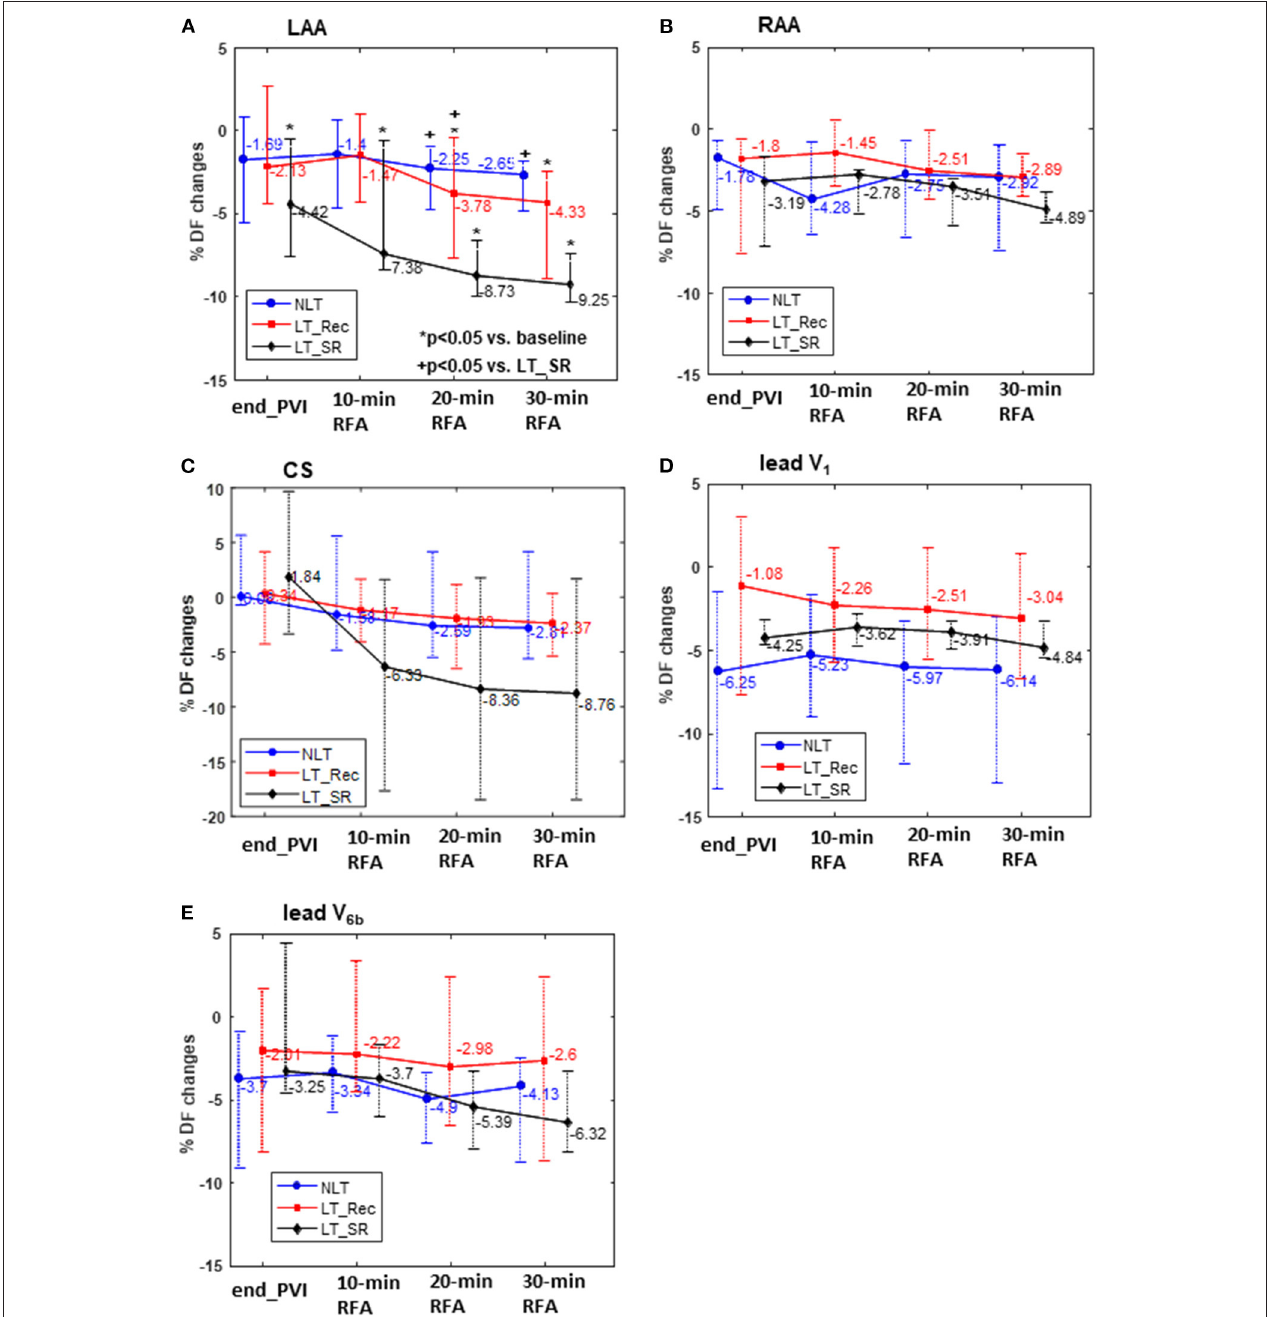
FIGURE 3 | Relative changes (%) in DF compared with the baseline DF at the end of PVI (endPVI) and during the first 10, 20, and 30min of cumulative ablation following PVI. DF was measured within the LAA, RAA, CS, and on the ECG leads V 1 and V 6b . RFA, radiofrequency ablation. Abbreviations as in previous tables and